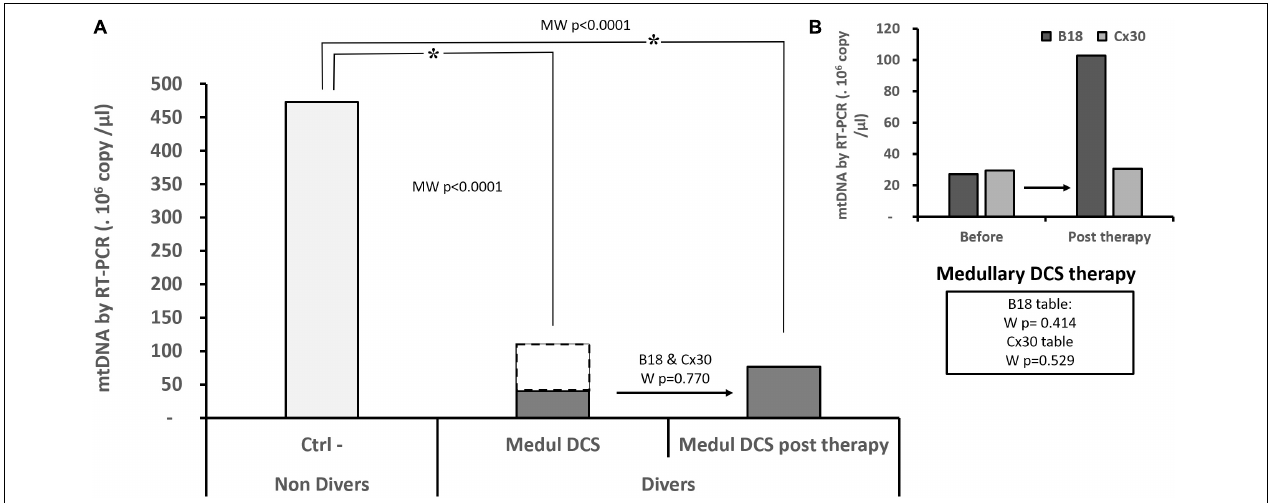
FIGURE 3 | Quantity of circulating mitochondrial DNA in the patients suffering from medullary DCS (A) , before and after treatment by B18 ( n = 14) or Cx30 ( n = 8) (B) . Only Medullary DCS patients with values before and after treatment are compared to the non-diving subject (Ctrl − , n = 22): the dots represent the totality of medullary DCS patients ( n = 57) (A) . Asterisk ( ∗ ) means that the statistical difference is significant. KW p < 0.0001 post hoc Conover-Iman with a corrected significance level (Bonferroni) of 0.0167. NS shows an absence of statistic difference for the paired samples (Wilcoxon test: